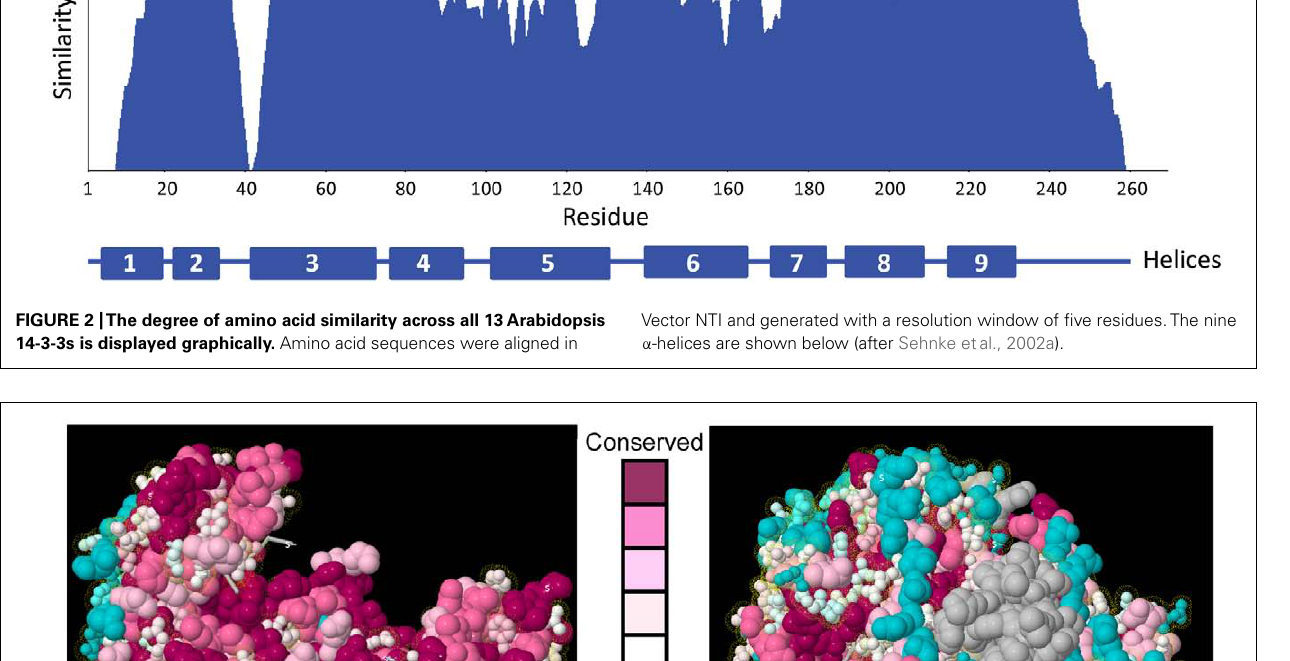
Vector NTI and generated with a resolution window of five residues.The nine α -helices are shown below (after Sehnke etal., 2002a).